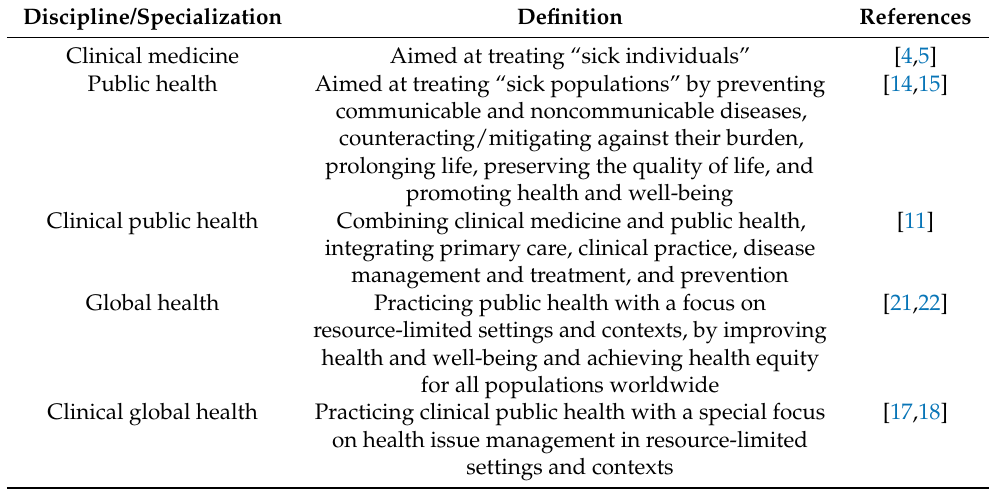
Table 2. Ways of approaching health and well-being at the individual and community/population